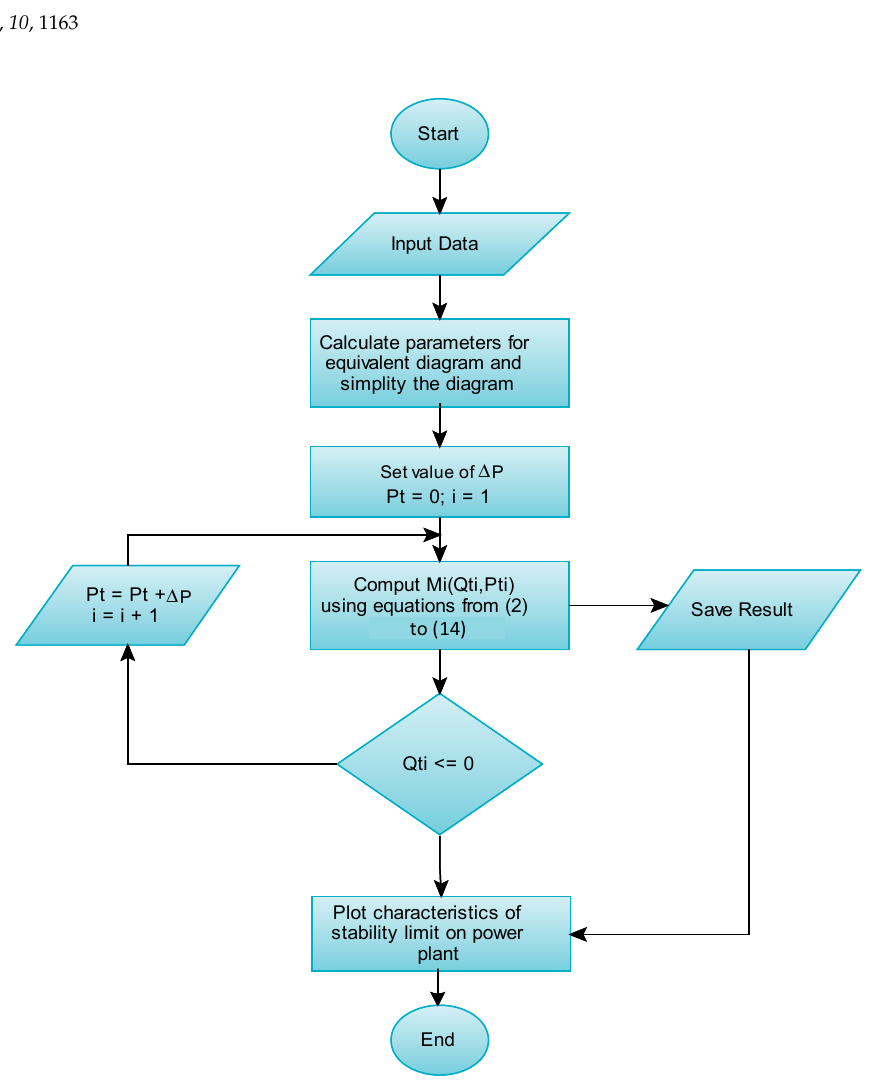
Figure 3. Algorithm for drawing the characteristics of the stability limit.